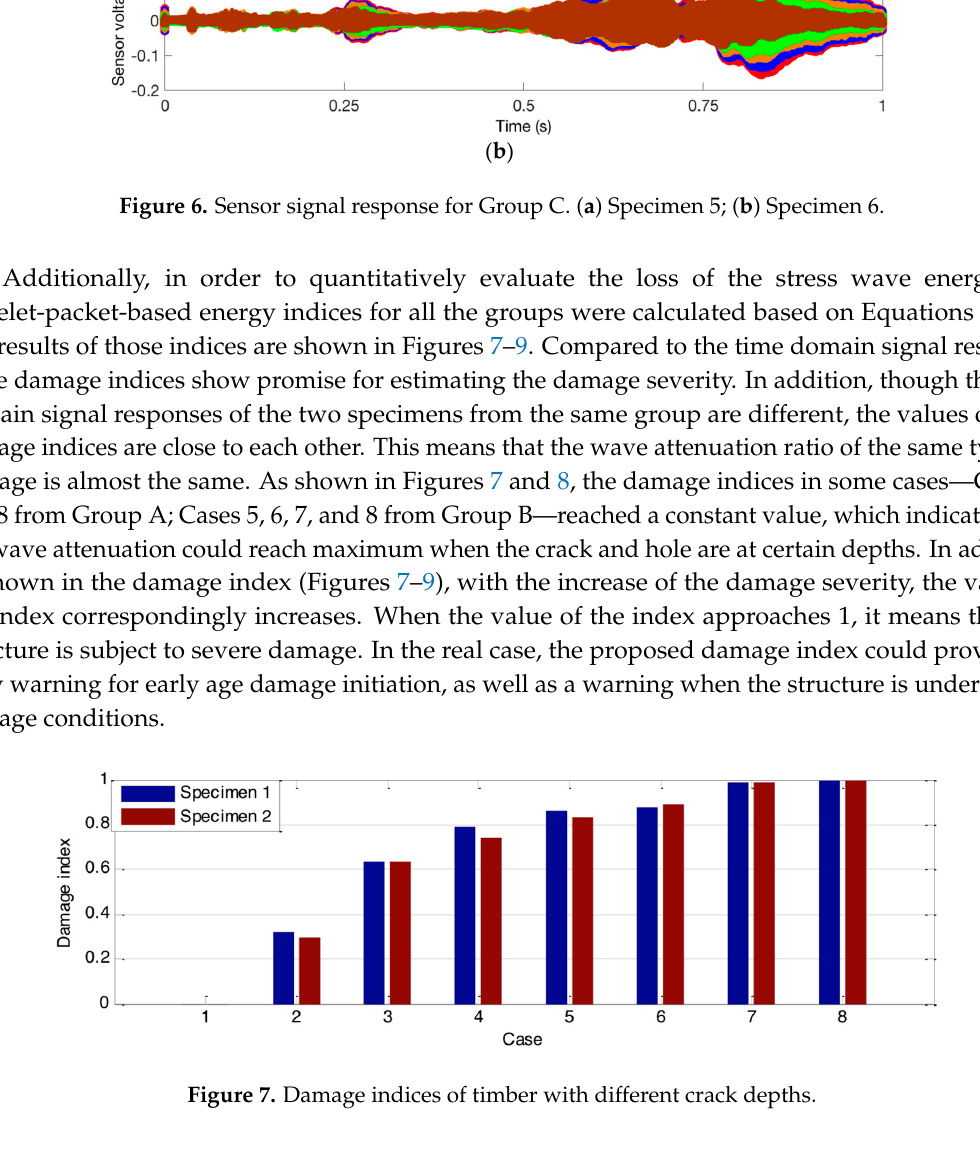
Figure 7. Damage indices of timber with different crack depths.